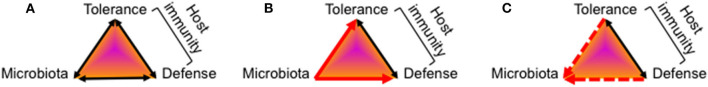
Mutual relationship between the host's immune system and the gut microbiota. The function of the host's gut mucosal immune system toward colonizing microbes is determined by the net sum of tolerance and defense activities which is depicted in a model of a triangular relationship. All elements of the triangle can be impacted by diverse environmental factors not included in this model. (A) Healthy gut colonization and immune adaptation mutually co-develops into a stable, energy-efficient state of homeostasis between the host's immune system and the microbiota. (B) Multiple evidence exists that after birth colonizing microbiota induce maturation of gut mucosal immunity by activation of tolerance-mediating signaling pathways as well as antimicrobial defense programs. (C) The knowledge on how the host's immune system at the beginning of life impacts on the kind of colonizing microbes and the further development of the microbiota composition is still fragmentary.